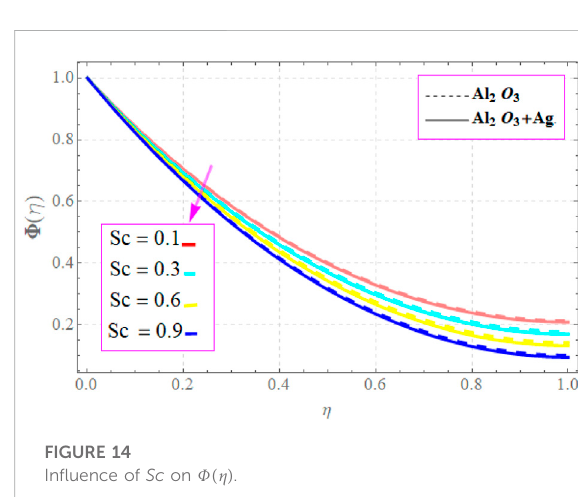
FIGURE 13 In fl uence of S on Φ ( η ) .